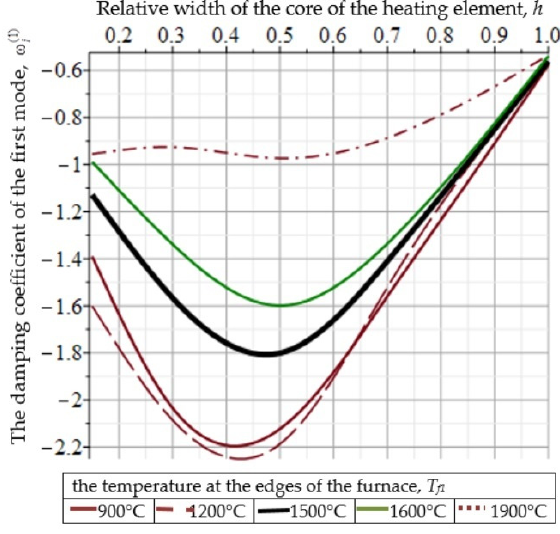
( 1 ) on h for various values of T f 1 ω i on h for various values of T f 1 . i